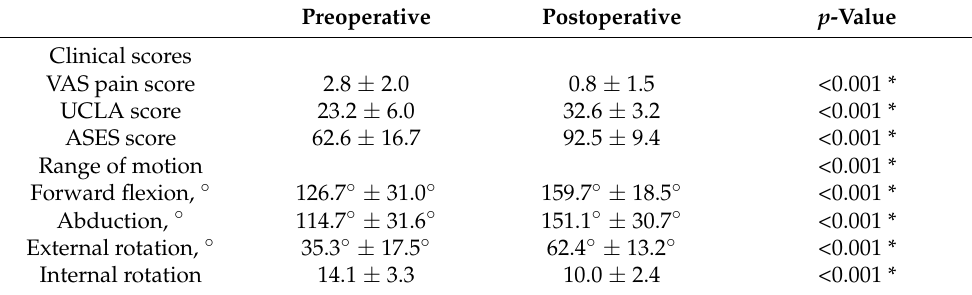
Table 3. Comparison of clinical outcomes before and after implant removal